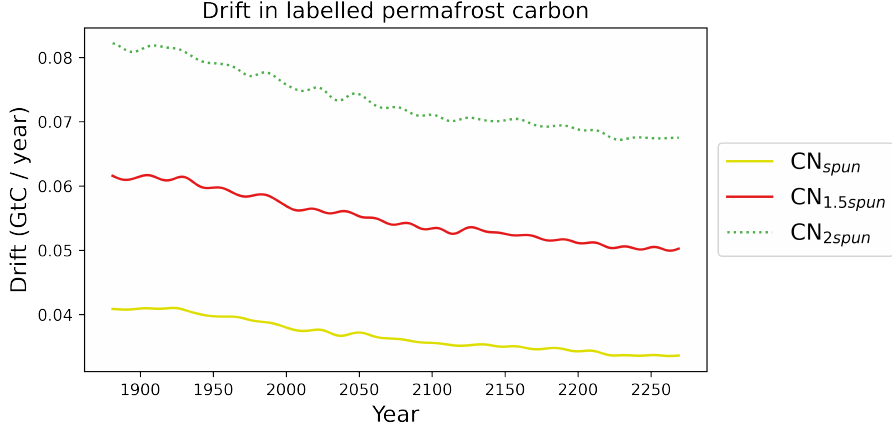
Figure A1. The annual loss of labelled permafrost carbon (in Gt C per year) caused by the on-going small exchange between the carbon above the permafrost table and permafrost carbon below the permafrost table (denoted labelled permafrost carbon in this paper) in a stable climate using the control-ens of the JULES-CN configuration.